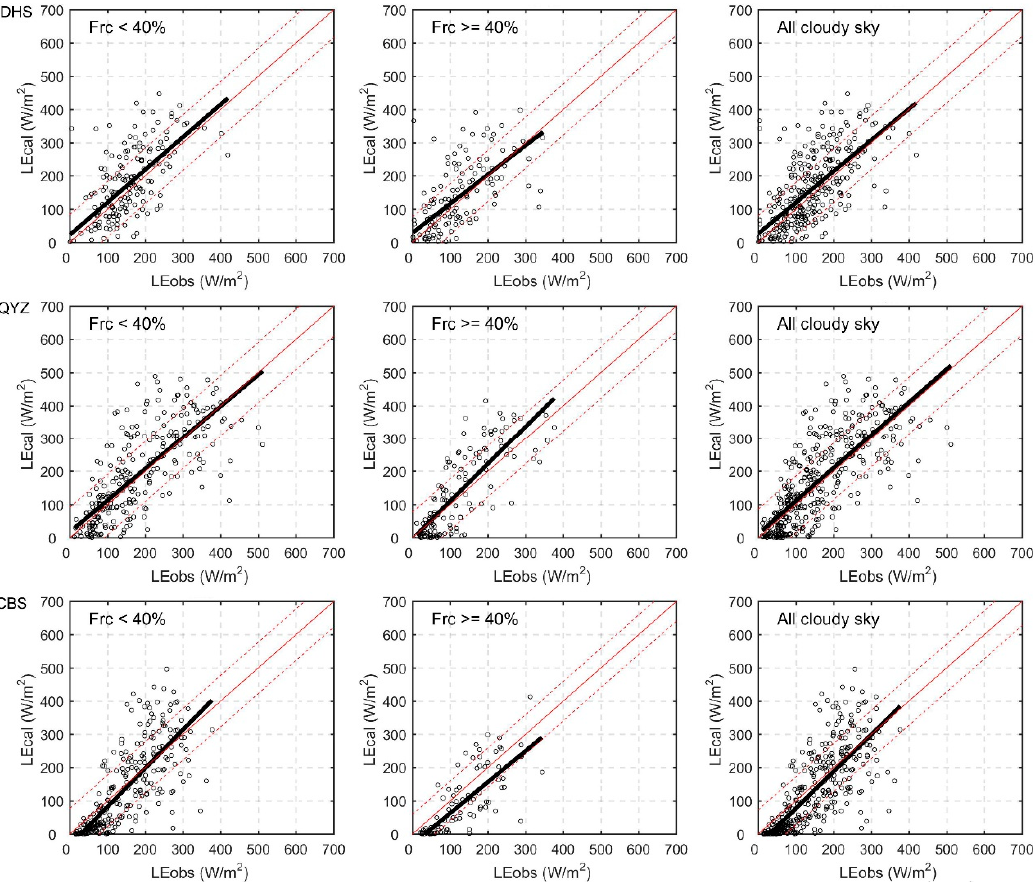
Figure 10. Validation of EDVI-based LE cal under di ff erent cloud cover (Frc). Partly cloudy sky (Frc < 40%), Cloudy sky (Frc >= 40%) and all cloudy sky (0% <= Frc <= 100%).